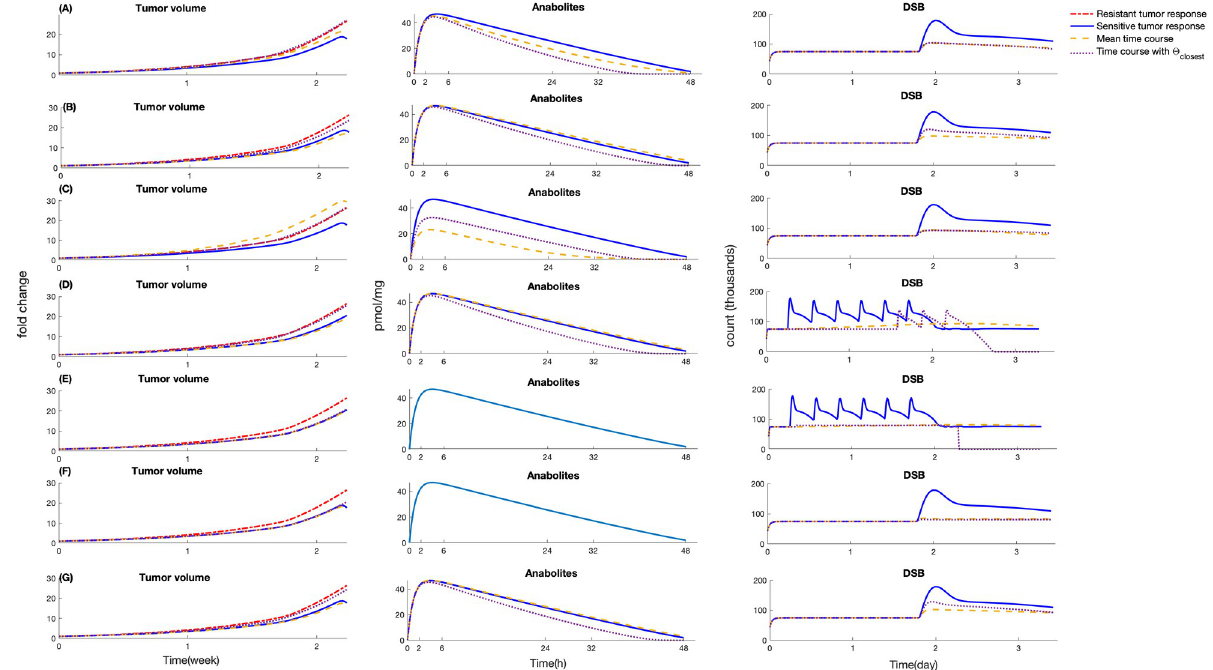
Fig 5. The simulation result of resistance analysis. The first column is the time profiles of tumor volume; second column, 5-FU anabolites, third column: 5-FU induced DSB. Each row represents each aforementioned scenario. Red dash-dotted line, model simulation of resistant LS174T xenograft tumor; blue solid line: model simulation of sensitive LS174T xenograft tumor; yellow dashed line, the mean time course of 500 computed time courses; Θ closest denotes the parameter set associated with the time course of tumor volume closest to the tumor resistance response; purple dotted line: the time course generated by Θ closest .